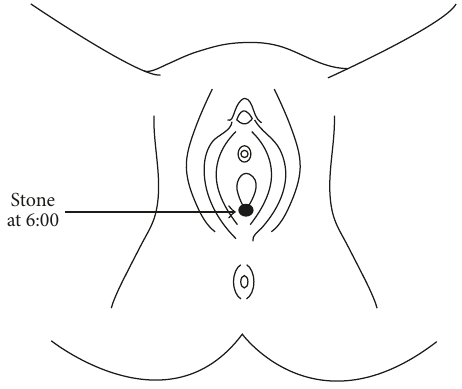
Figure 1: Diagram of the 5 × 8 mm stone at the vaginal fourchette.